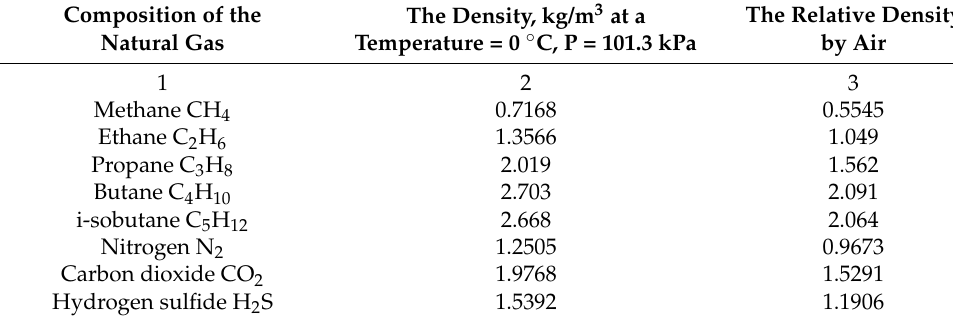
The Relative Density by Air